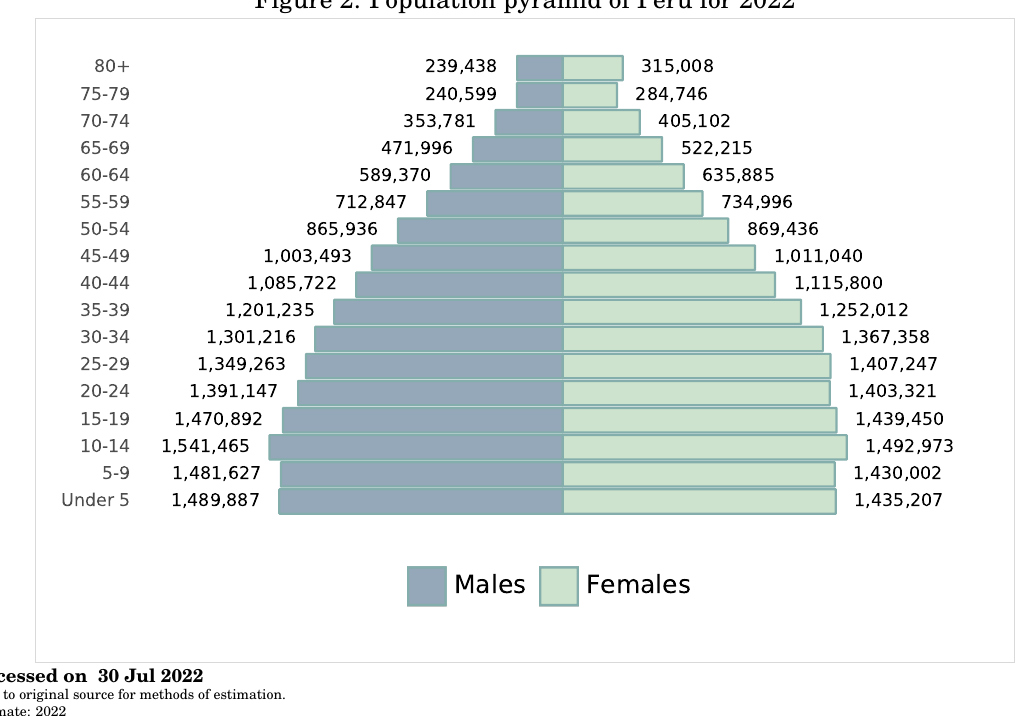
Figure 2: Population pyramid of Peru for 2022